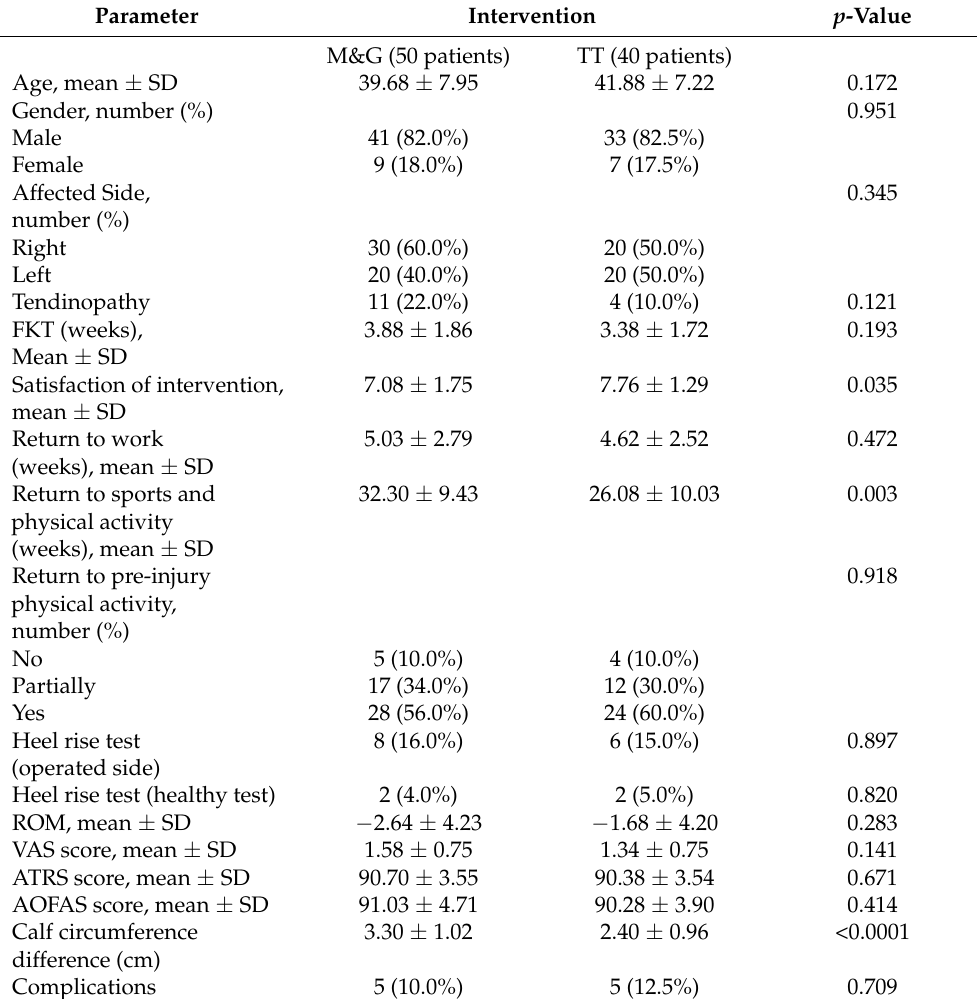
Table 2. Comparison of demographics and clinical outcomes between the M&G and T